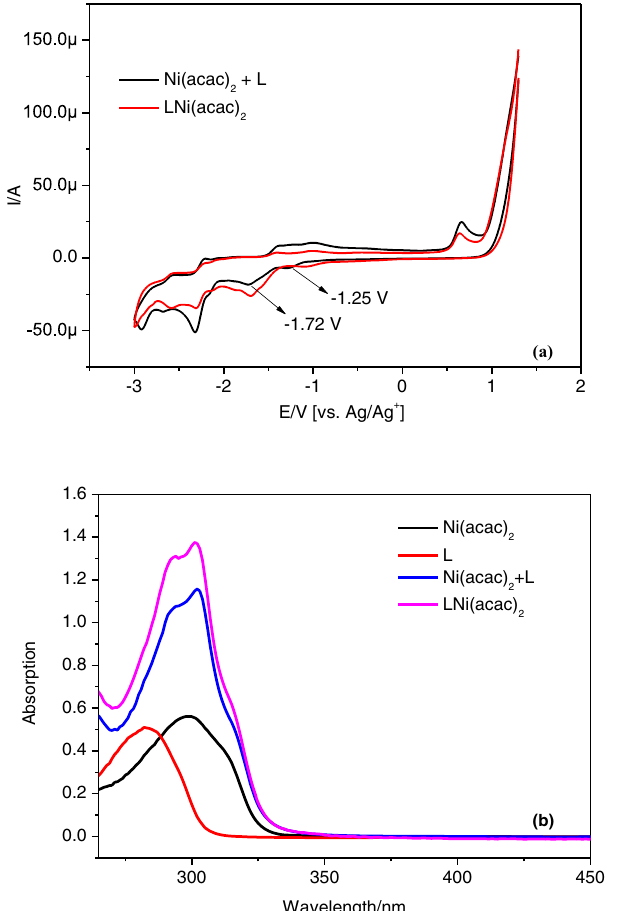
Fig. 6 Electrochemical and spectroscopic investigations. a CV tests of [Ni(acac) 2 + L] and LNi(acac) 2 . Testing conditions: working electrode, glassy carbon electrode; counter electrode, Pt wire; reference electrode, Ag/AgNO 3 electrode (10 mM AgNO 3 in CH 3 CN). Scan rate: 100 mV/s. Solvent: NMP/ n Bu 4 NPF 6 (0.1 M). Samples were tested under N 2 atmosphere. Ni(acac) 2 , 3 mM; L, dtbbpy, 3 mM, LNi(acac) 2 , 3 mM. b UV- vis spectra of Ni(acac) 2 , 3 × 10 − 5 M; L, 3 × 10 − 5 M; [Ni(acac) 2 + L], 3 × 10 − 5 M + 3 × 10 − 5 M and LNi(acac) 2 , 3 × 10 − 5 M. NMP is chosen as the testing solvent. L = dtbbpy, 4,4 ′ -di-tert-butyl-2,2 ′ -bipyridine; NMP = 1- methyl-2-pyrrolidinone.